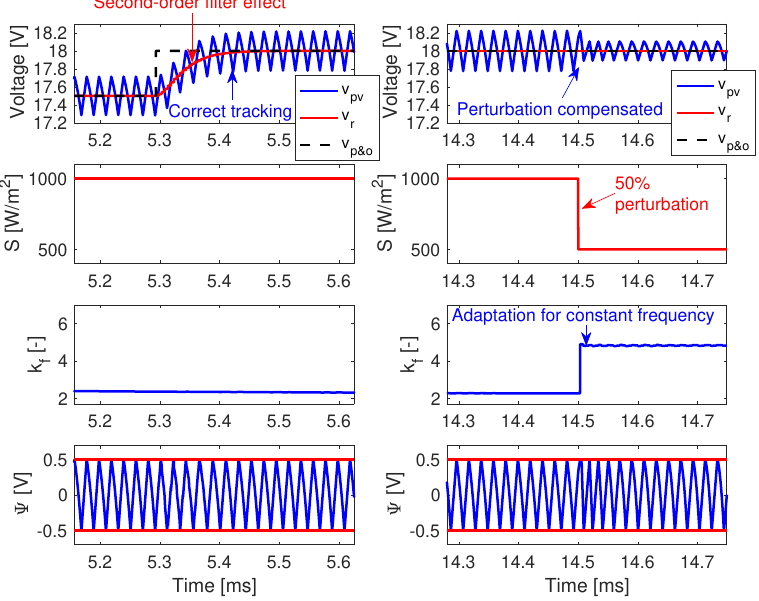
Figure 13. Detail of the SMC performance for reference tracking ( left ) and perturbation compensa- tion ( right